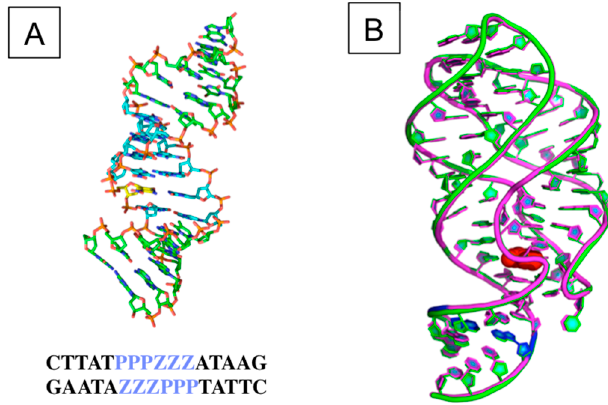
Figure 2. Crystal structures with Z:P AEGIS pairs: ( left ) A 16-mer duplex with six consecutive Z:P pairs [82]; ( right ) A single Z:P pair containing a RNA guanine riboswitch superimposed to its natural counterpart [92].